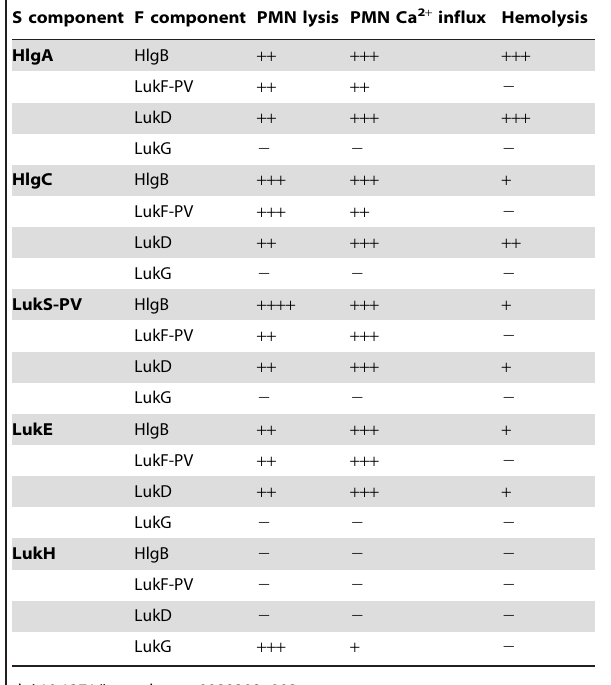
Table 2. Characteristics of heterologous toxin combinations.